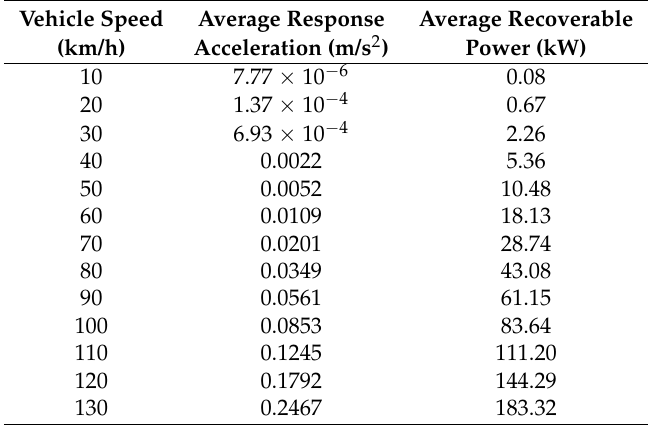
Table 3. Simulation result of the quarter vehicle magnetic spring model excited by measured road roughness road data at varying vehicle speeds.